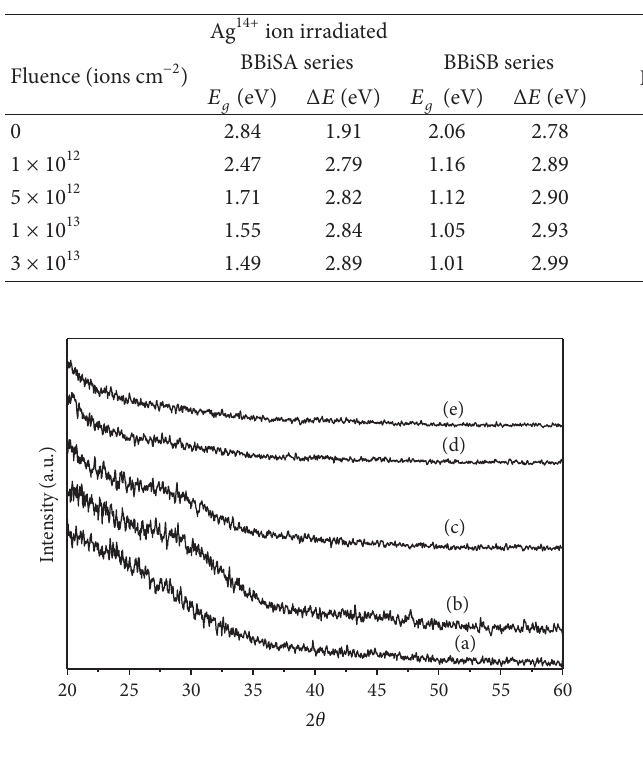
ion-irradiated 3+